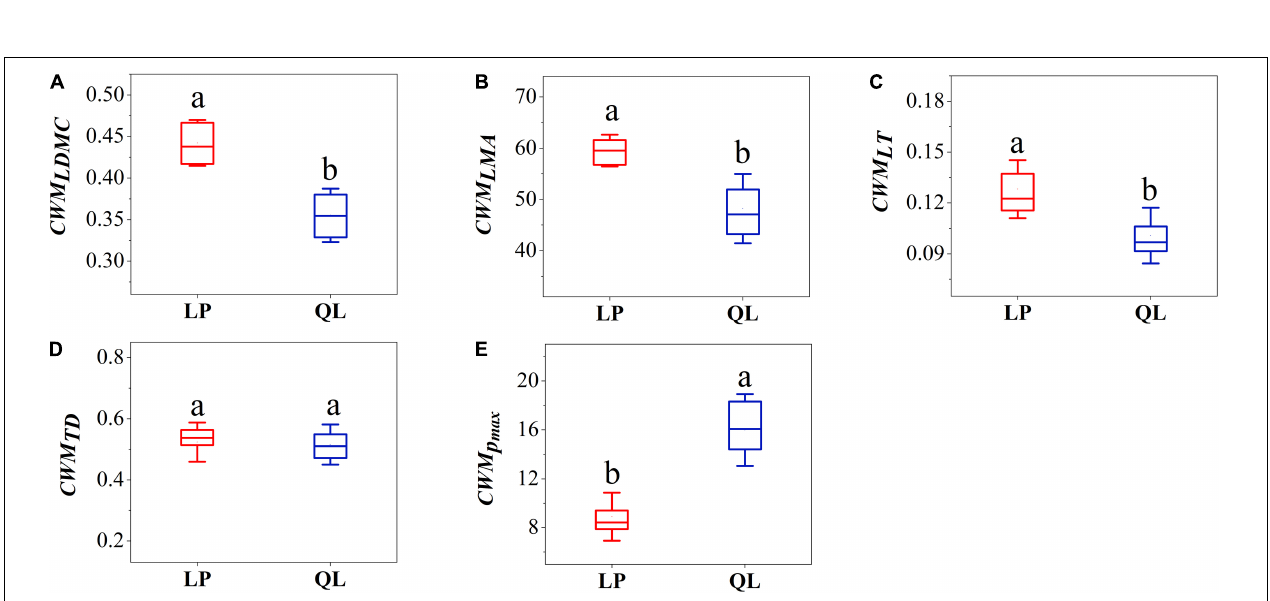
FIGURE 2 | Box-plot comparing community-weighted mean value of (A) leaf dry matter content, (B) leaf dry mass per area, (C) leaf thickness, (D) leaf tissue density, (E) maximum net photosynthetic rate between LP and QL. Different letters indicate significant differences ( P < 0.05).